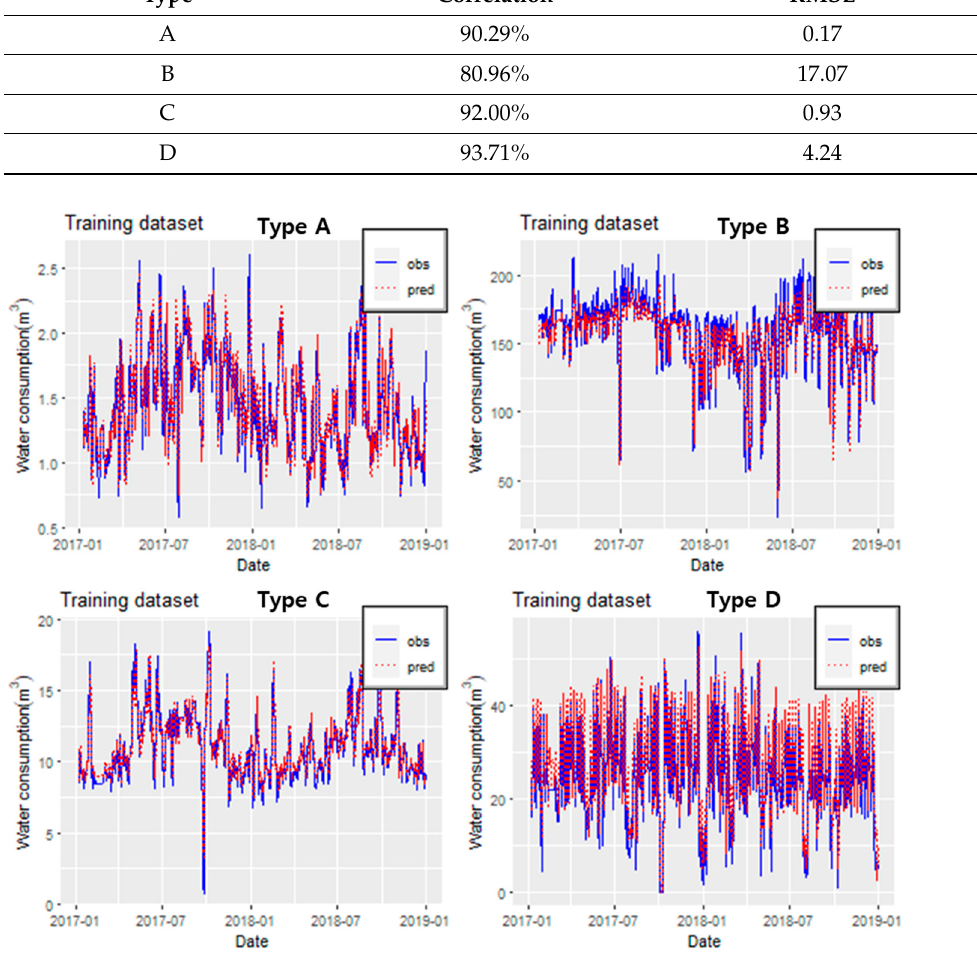
Figure 9. Time series of the predicted and observed values of the LSTM model (training dataset).